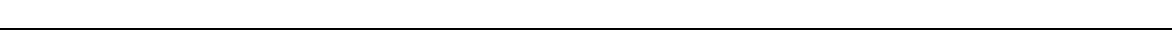
Fig. 4 Appropriate level of DLC1 activity is required for directional migration of NCCs. a Time-lapse imaging showing the protrusion dynamics of emigrating NCCs expressing GFP control, DLC1 and DN-DLC1. White arrows indicate protrusions direction. Polar histogram plots showing distribution of the angle between actin protrusions and subsequent migration direction from all the time series. n = 22/10 explants for GFP control, n = 20/12 explants for DLC1, n = 25/12 explants for DN-DLC1. Scale bar, 20 μ m. b Migration tracks of 17 representative NCCs expressing GFP control, DN-DLC1 and DLC1 are shown. Quanti fi cation of the total migratory distance c , persistence d , net speed e and total speed f of NCCs electroporated with the indicated constructs. GFP and non-GFP cells serve as controls. Mean ± s.e.m. Student ’ s t -test, *** p < 0.0001; ** p < 0.001; ns, not signi fi cant. g Schematic diagram showing the back (side B) and front side (side A) of a neural crest cell migrating toward SDF-1 coated beads. Scale bar, 50 μ m. h Processed FRET signal images of time-lapse series of emigrating NCCs from neural tube explants treated with vector control ( n = 111/16 explants), DLC1 ( n = 93/17 explants) and DN-DLC1 ( n = 88/13 explants). Scale bars, 50 μ m. i Quanti fi cation of the ratio of the FRET index between the back (B) and front (A) of the cluster for the indicated conditions. Mean ± s.e.m. Student ’ s t -test, *** p <